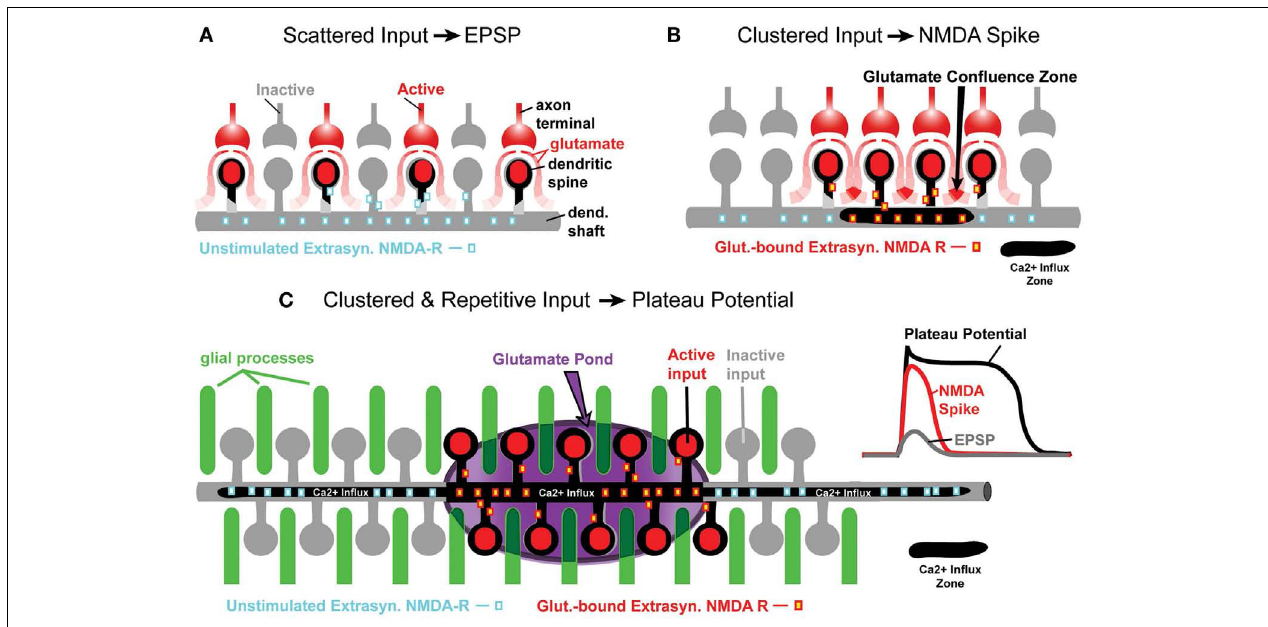
dendritic spines. Darker green indicates less glutamate uptake in glial process, or release of glutamate from the glial process. For a period of time, an entire segment of the spiny dendrite is surrounded by extracellular matrix rich in glutamate (“glutamate pond”) – marked by purple ellipsoid.The Ca 2 + influx zone now includes spines and dendritic shaft below spines.The Ca 2 + influx occurring proximally and distally to the clustered synaptic input site is due to bi-directional propagation of dendritic plateau potential, which initiated inside the glutamate pond. Inset traces: schematic representation of dendritic voltage waveforms associated with EPSPs, NMDA spikes, and plateau